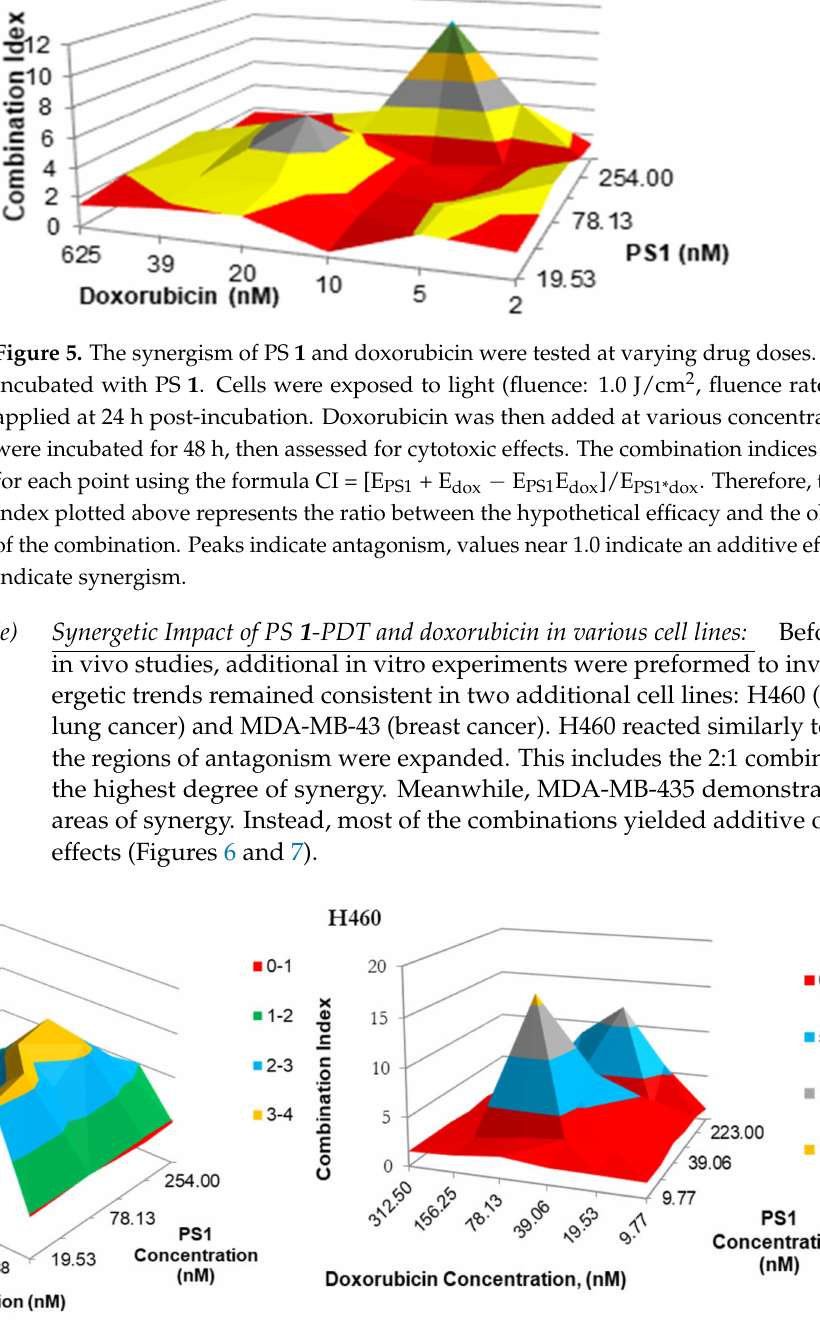
Figure 6. The synergism of PS 1 and doxorubicin tested MDA-MB-435 in H460 and at varying drug doses. Cells were plated and PS 1 was added. Cells were exposed to light (fluence: 1.0 J/cm 2 , fluence rate: 75 mW/cm 2 ) at 24 h post-incubation. Doxorubicin at various doses was then added, and cells were incubated for 48 h, then assessed for cytotoxic effects. The combination indices were calculated for each point using the formula CI = [E PS1 + E Dox − E PS1 E Dox ]/E PS1+Dox . Peaks indicate antagonism, values near 1.0 indicate an additive effect, and valleys < 1.0 indicate synergism. Areas indicated in red denote synergetic concentrations and valleys < 1.0 indicate synergism. Areas indicated in blue and red denote synergetic